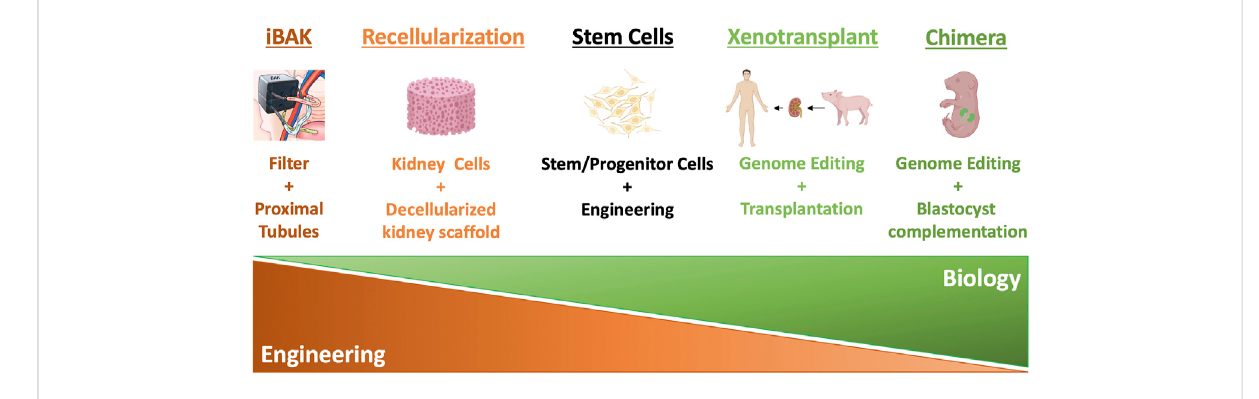
FIGURE 1 Summary of different kidney replacement approaches.